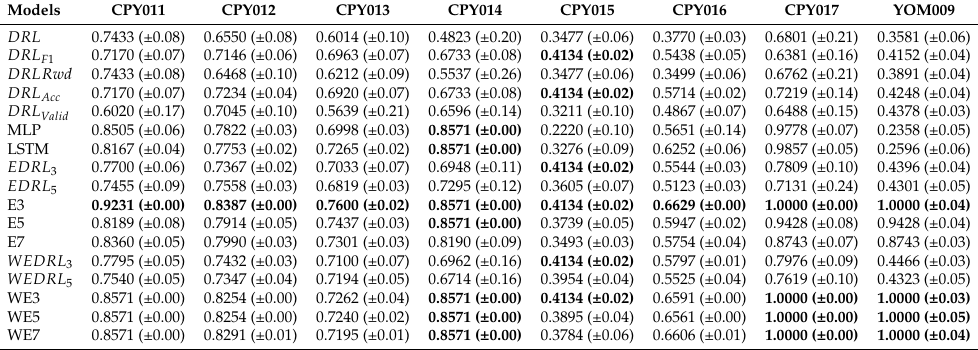
Table 13. The mean F1-scores and standard deviation of all models when testing with the dataset from different stations (the best F1-score of each station is shown in